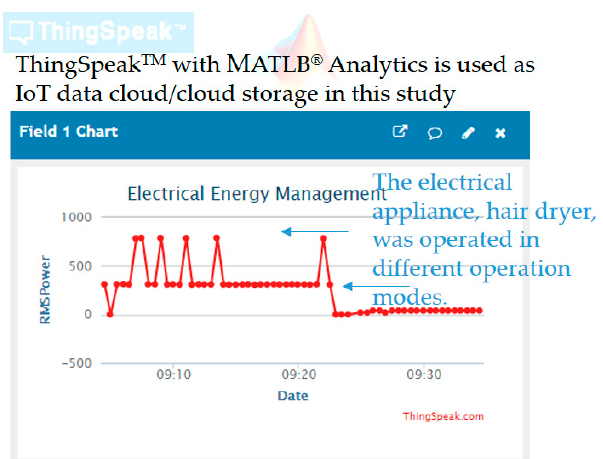
Figure 10. Simple web page visualizing electrical energy consumption identified by the developed smart autonomous power meter prototype in this